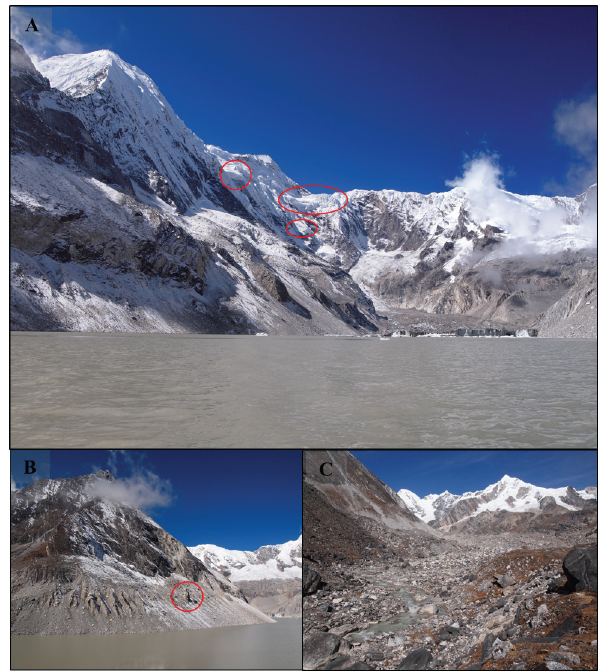
Figure 9. Lumding Tsho and its surrounding slopes with areas of concern highlighted in red showing (a) the calving front and prone areas behind the glacier, (b) the southern side slope, and (c) the terminal moraine and its gentle